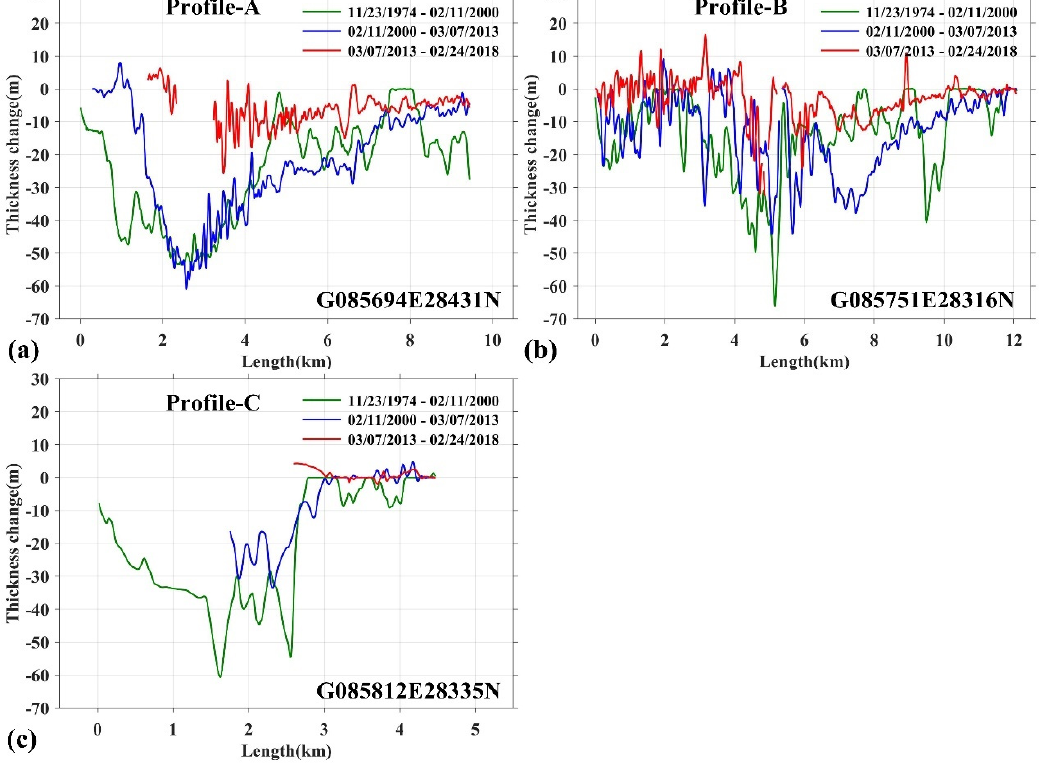
Figure 9. Changes in glacier thickness along three profiles. The location of subfigure ( a – c ) is shown in A, B and C of Figure 8c, respectively.